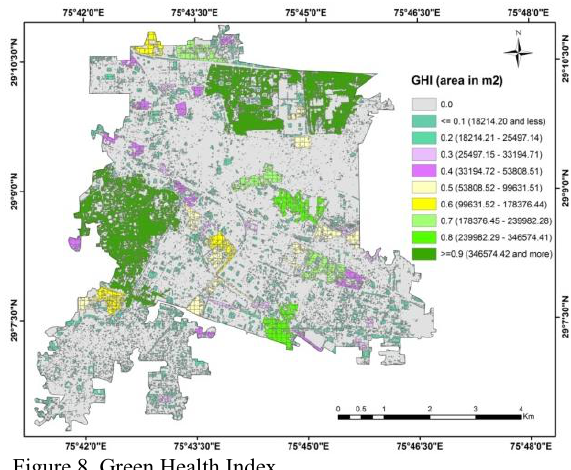
Figure 8. Green Health